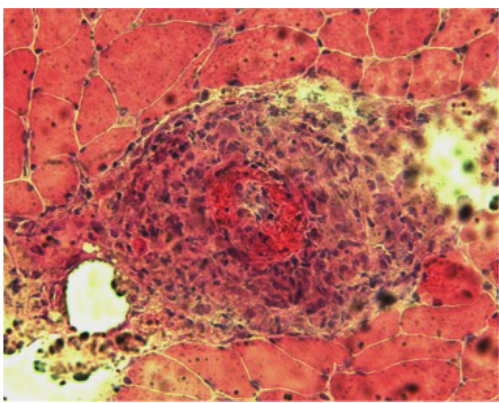
Figure 1: Biopsy findings of left biceps muscle. Inflammatory cells infiltrated perivascular area and variation in muscle fiber size and central nucleation were seen, indicating the presence of myositis. Medium-sized artery showed stenosis and occlusion of lumen with fibrinoid necrosis, indicating necrotizing vasculitis. No formation of granuloma was seen.